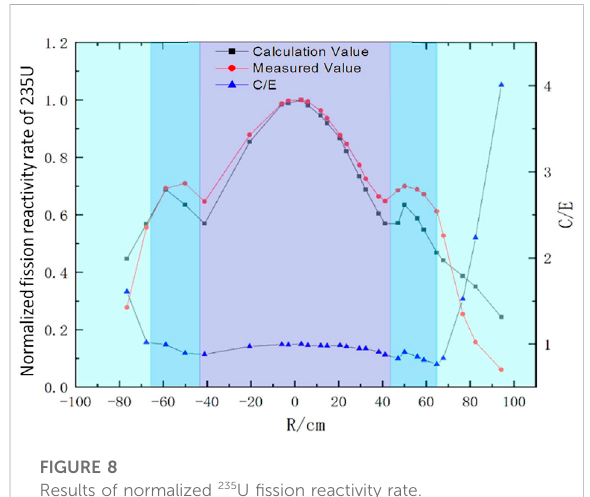
FIGURE 8 Results of normalized 235 U fi ssion reactivity rate.